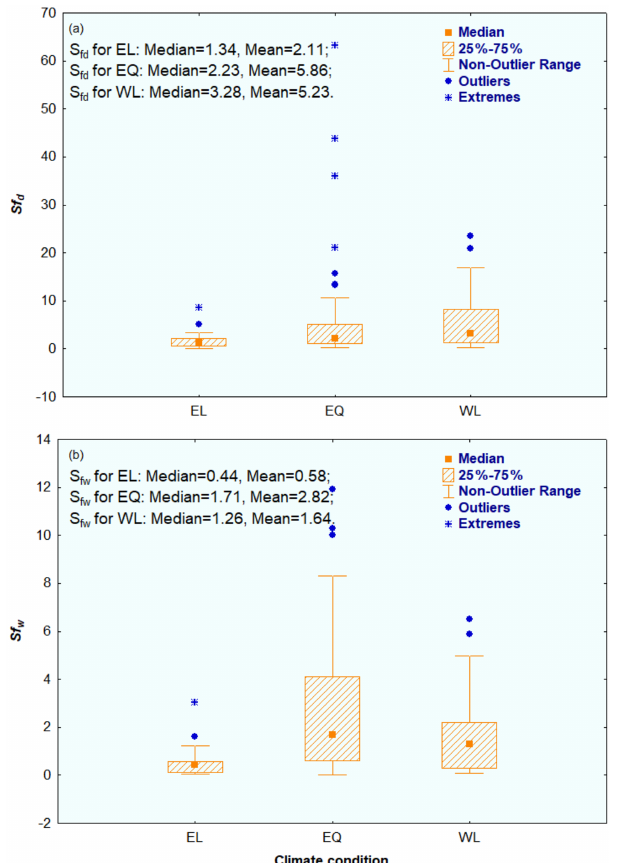
Figure 4. Comparisons of ecohydrological sensitivity grouped by dominant soil type in the (a) dry season and (b) wet